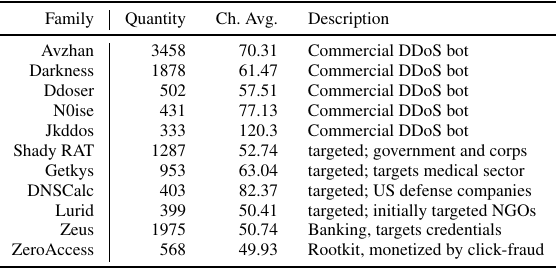
Table 2. Malware families used in the evaluation of Chatter, including set size and the average number of events per execution